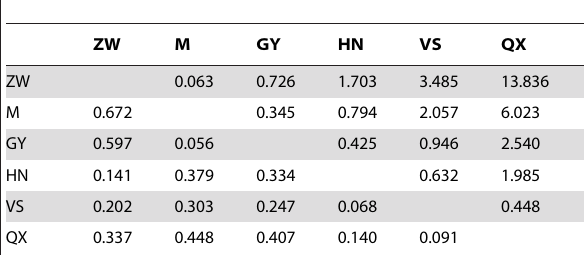
Table 2. Slatkin’s (1995) genetic distances ( F ST /1– F ST ) based on mtDNA cytochrome b (above diagonal) and microsatellite data (below diagonal),